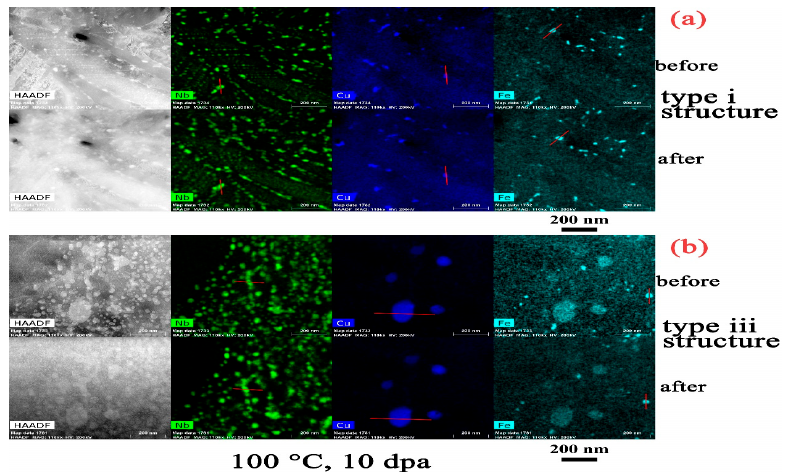
Figure 2. HAADF (High-angle annular dark-field) and Chemi-STEM micrographs showing the distribution of Nb, Cu, and Fe alloying elements before and after heavy ion irradiation at 100 °C to 10 dpa in ( a ) type i and ( b ) type iii structures. Red lines in the maps indicate the precipitates used for the element distribution line profile measurement.